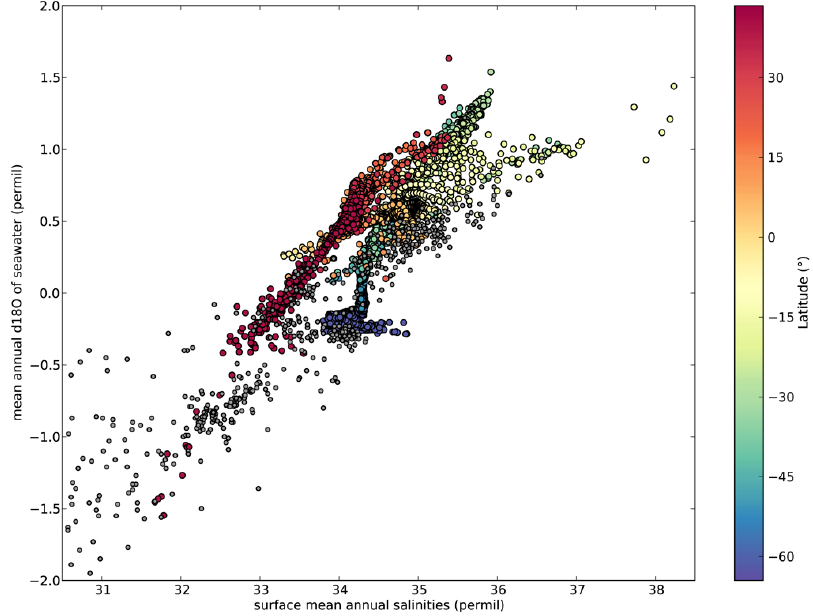
Fig. 11. Near-surface ocean annual δ 18 O-salinity relationship in i LOVECLIM (coloured dots) and GISS database (grey dots) (Schmidt et al., 1999) for the Pacific Ocean. Colour scale indicates the latitude for the i LOVECLIM